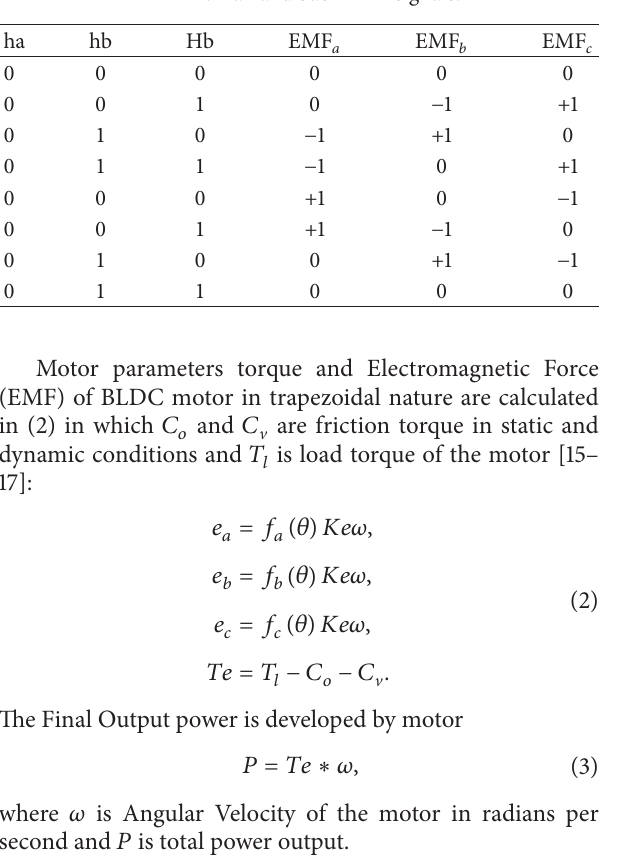
Table 1: Hall and back EMF